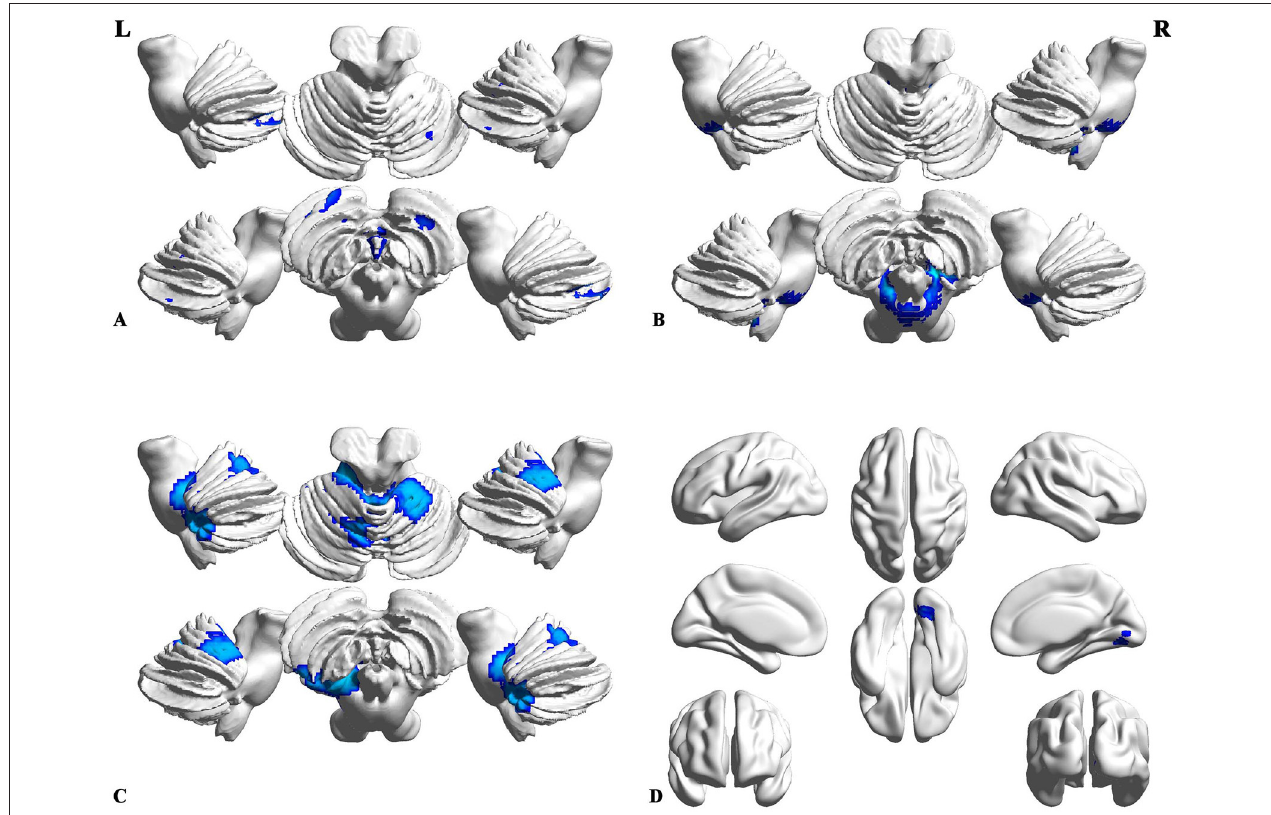
FIGURE 1 | Differences of structure, regional cerebral blood flow (rCBF), and function between the patients with MSA-c and MSA-p. (A) Compared to the patients with Parkinson-type of multiple system atrophy (MSA-p type), patients with data of cerebellum-type of MSA (MSA-c type) showed significantly decreased gray matter (GM) volumes in right cerebellum_1, cerebellum_6 and cerebellum_8, left cerebellum_2, cerebellum_1, cerebellum_7b, cerebellum_4_5, vermis_4_5, and vermis_3; (B) MSA-c presented significantly decreased white matter (WM) volumes in bilateral cerebellum_9 and left cerebellum; (C) MSA-c presented decreased rCBF in the bilateral cerebellum_4_5 and vermis_4_5. (D) Decreased amplitude of low-frequency fluctuations (ALFF) values were found in the right lingual gyrus (LG) and fusiform (FFG).